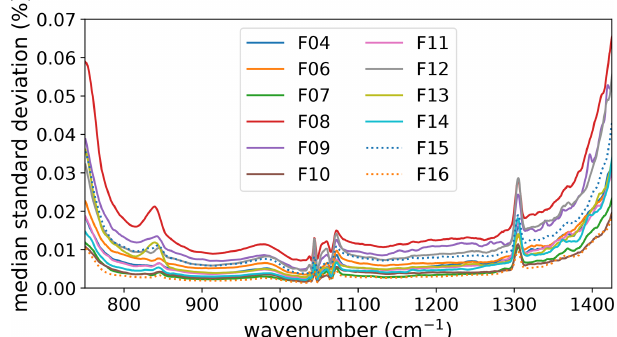
Table 4. Simplified estimates for the examined error sources.